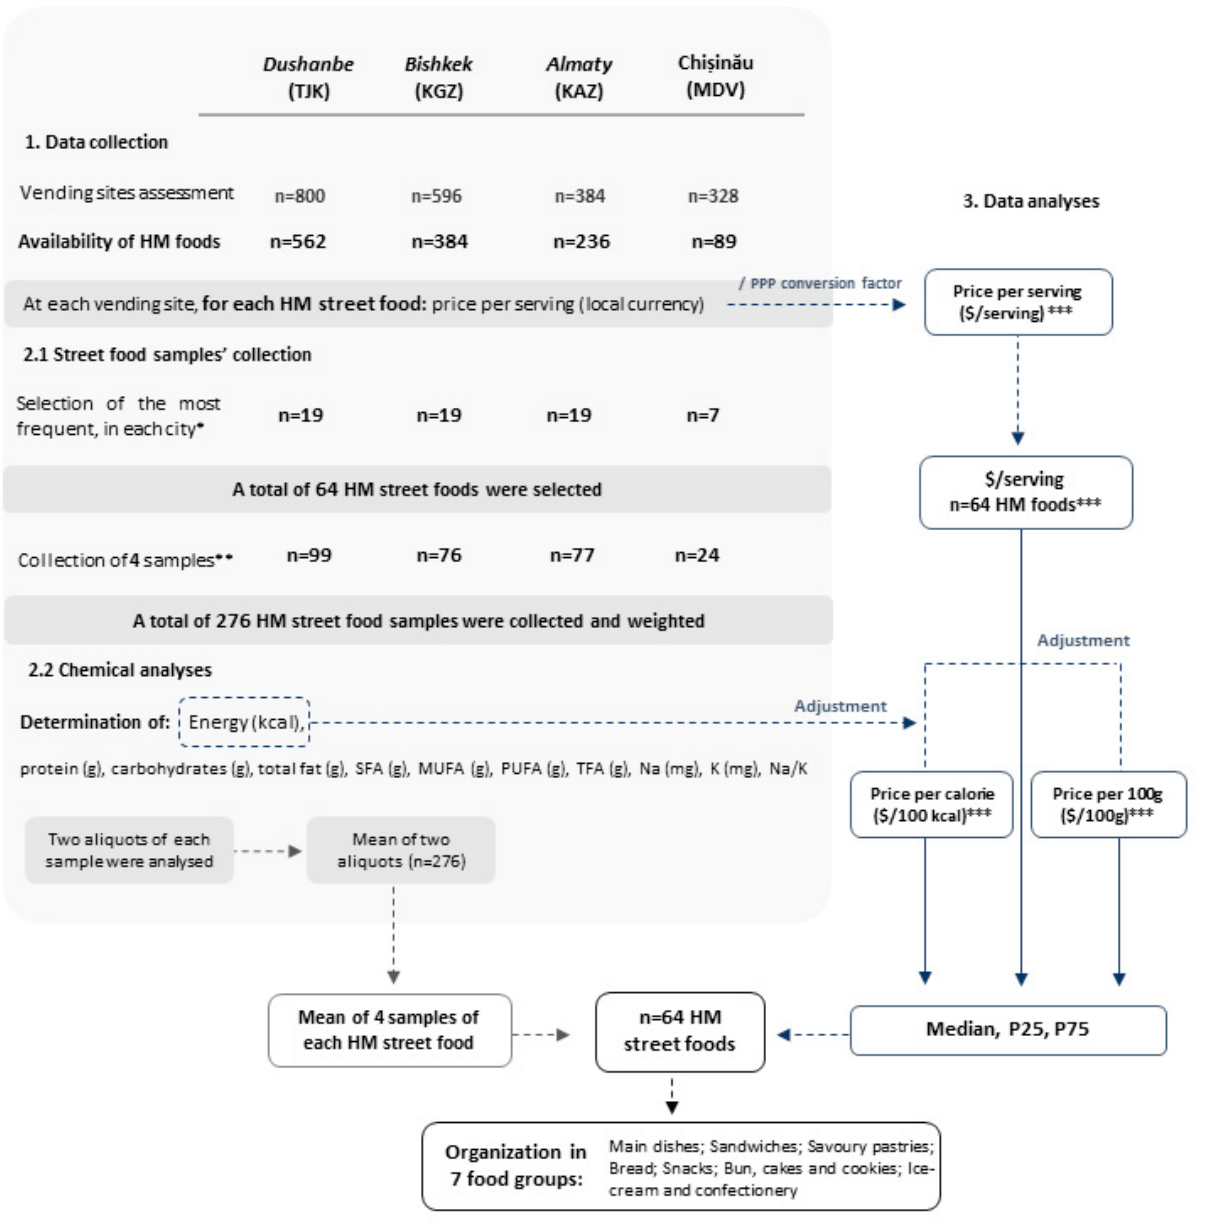
Figure 1. Flowchart of the sampling procedure, data and food samples’ collection and analyses, conducted in Dushanbe (Tajikistan), Bishkek (Kyrgyzstan), Almaty (Kazakhstan) and Chis